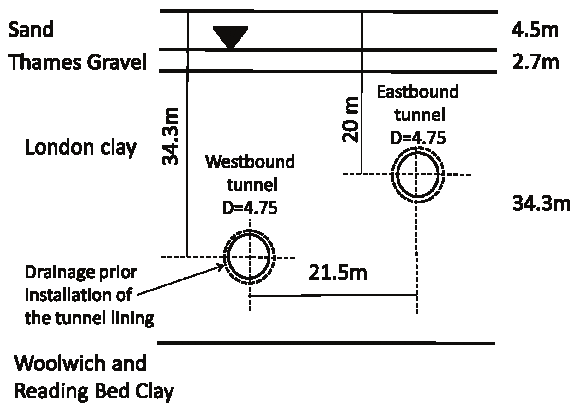
Fig. 6. Soil stratigraphy and diagonally oriented tunnels